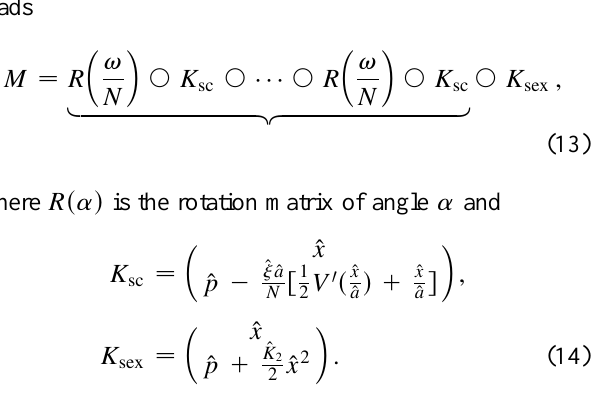
FIG. 6. (Color) Area and emittance of the extracted beam A x (cid:1) pe x versus extraction time during the extraction of the red stripe of particles on the top